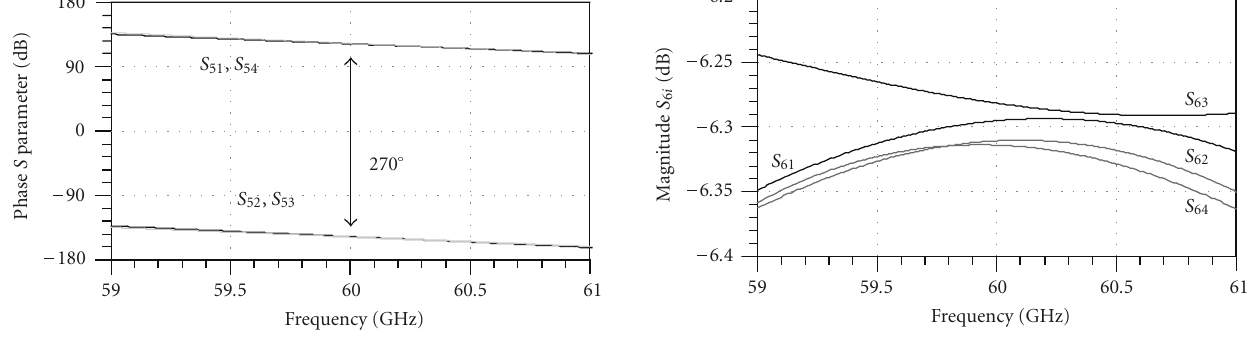
Figure 7: Simulation results of S 6 i magnitudes at RF input.